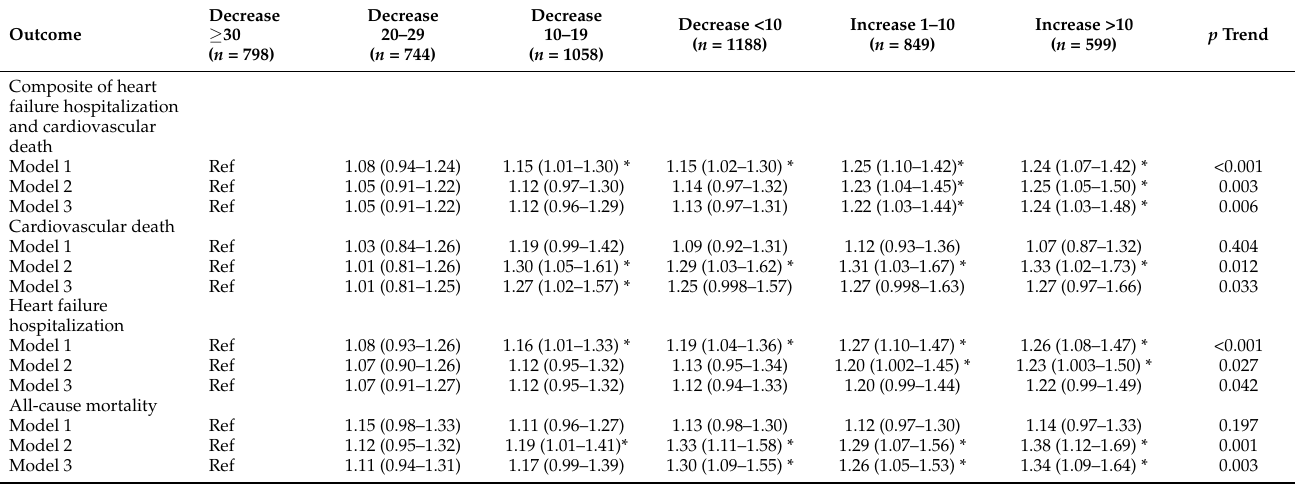
Table 3. Outcomes of patients grouped by changes in heart rate.